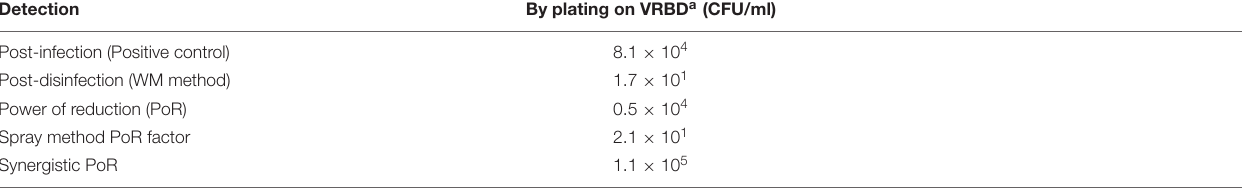
TABLE 6 | The result of one artificially contaminated beef with EDL933 treated with the VV method. Detection